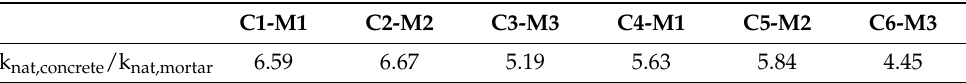
Table 20. Ratio of carbonation coefficient (k nat,concrete /k nat,mortar ) for strength classes C25/30 and C30/37 of specimens exposed in Xanthi.